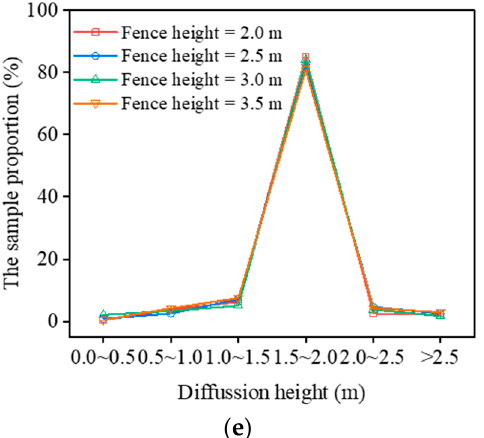
Figure 7. Distribution of diffusion height sample points of NPSD particles above enclosure under different enclosure heights and wind speeds. ( a ) Wind speed v =1 m/s; ( b ) v =2 m/s; ( c ) v =3 m/s; ( d ) v = 4 m/s; and ( e ) v = 5 m/s.